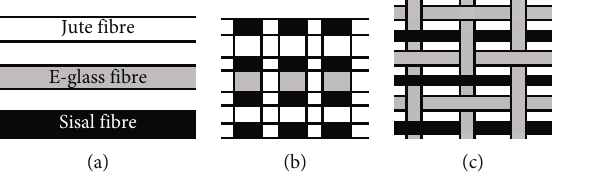
Figure 2: Di ff erent arrangements of fi bre in epoxy composite: (a) zero orientation, (b) 0- and 90-degree cross-orientation, and (c) intralaminar.